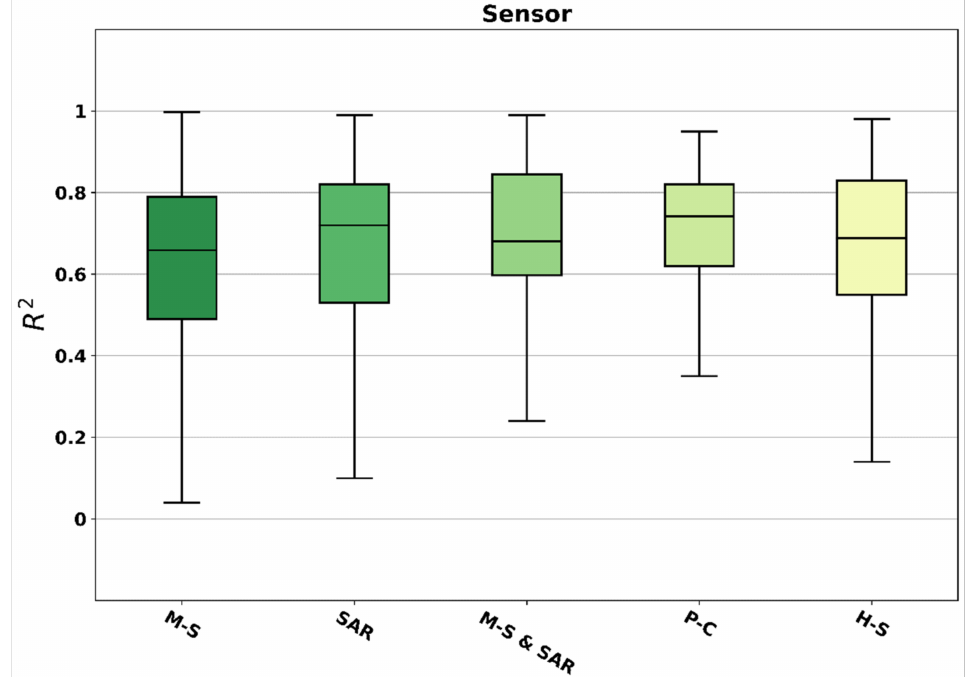
Figure 20. The coefficient of determination (R 2 ) of various sensors (M-S: multispectral; P-C: point- cloud; H-S: hyperspectral).